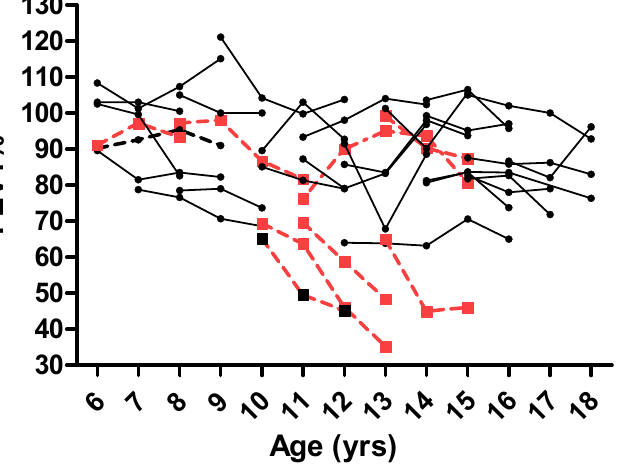
Figure 3. Lung function progress (FEV 1 %) for the whole population in the study period. Dotted